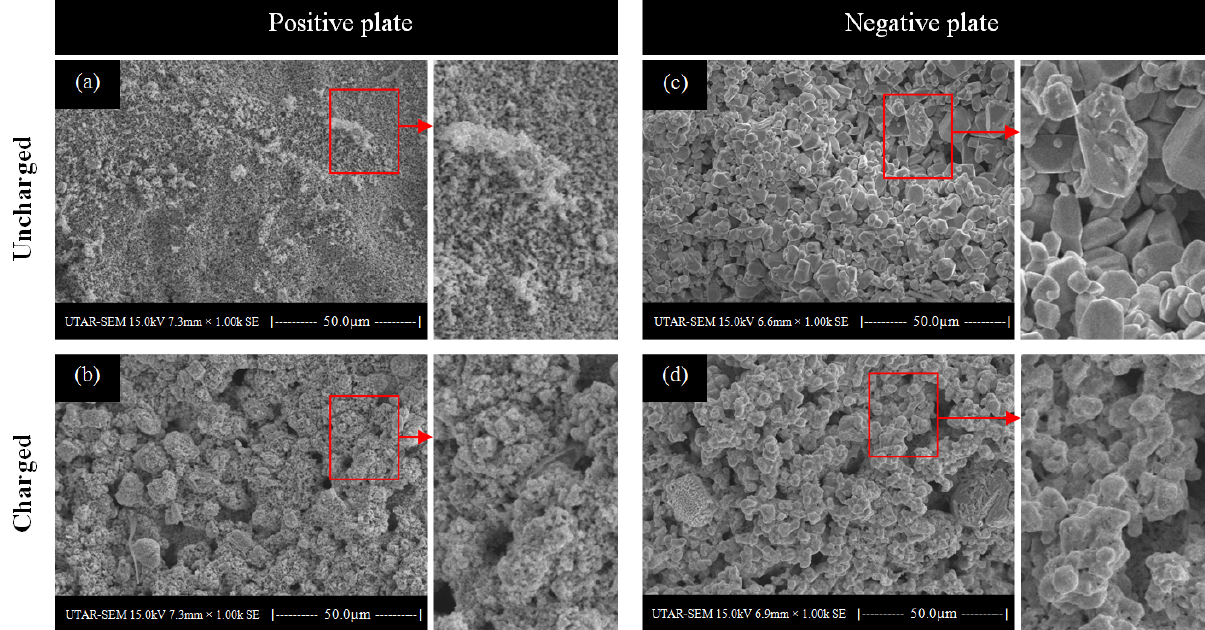
Figure 11. Microscopic scans of the recovered positive ( a , b ) and negative plates ( c , d ) before and after recovery.